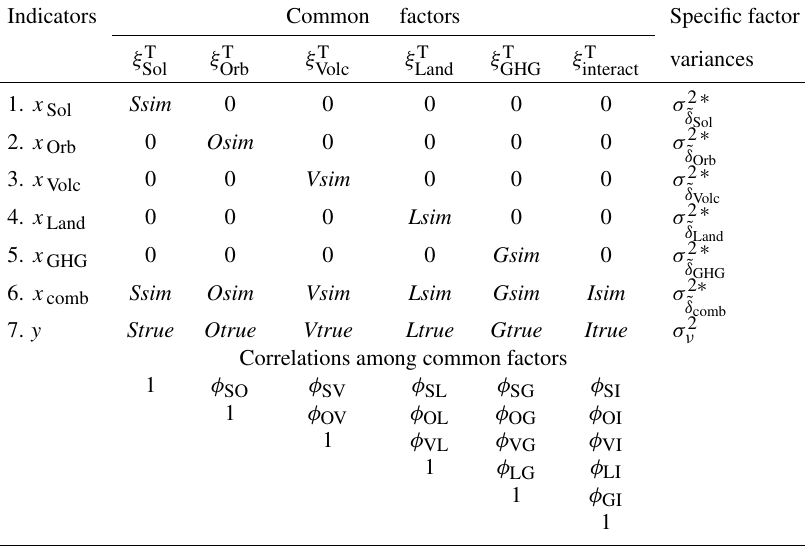
Table 2. Parameters of the seven-indicator and six-factor model, abbr. CFA(7, 6) model, arising as a result of relaxing the hypotheses of CFA(7, 6) model in Table